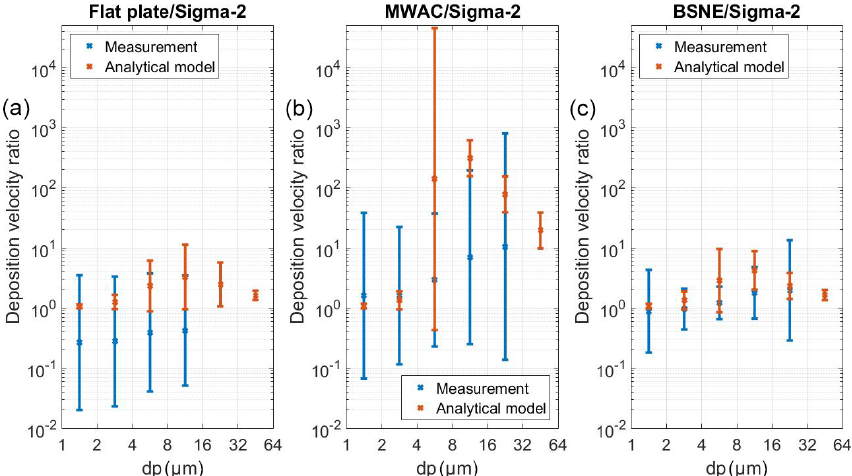
Figure 8. Comparison of geometric mean ratio of deposition velocities for different sampler pairs derived from measured deposition rates (blue) and from corresponding deposition models (orange). (a) Flat plate/Sigma-2; (b) MWAC/Sigma-2; (c) BSNE/Sigma-2. Error bars show geometric standard deviations. The bars show the central 95% confidence interval of the daily variation. The corresponding deposition models are listed in Table